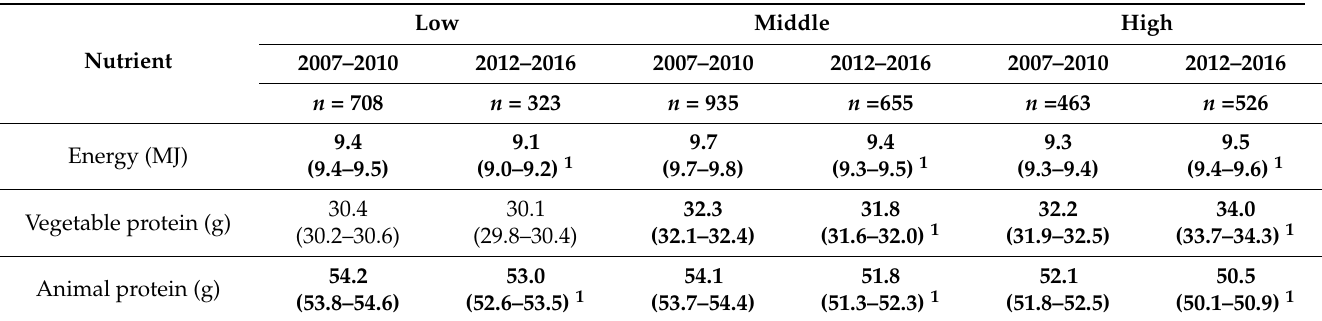
Table 7. Habitual mean ¥ (95%CI) * nutrient intake per day from food sources only for Dutch adults aged 19–69 years in 2007–2010 ( n = 2106; DNFCS 2007–2010) and 2012–2016 ( n = 1540; DNFCS 2007–2010) by educational level.